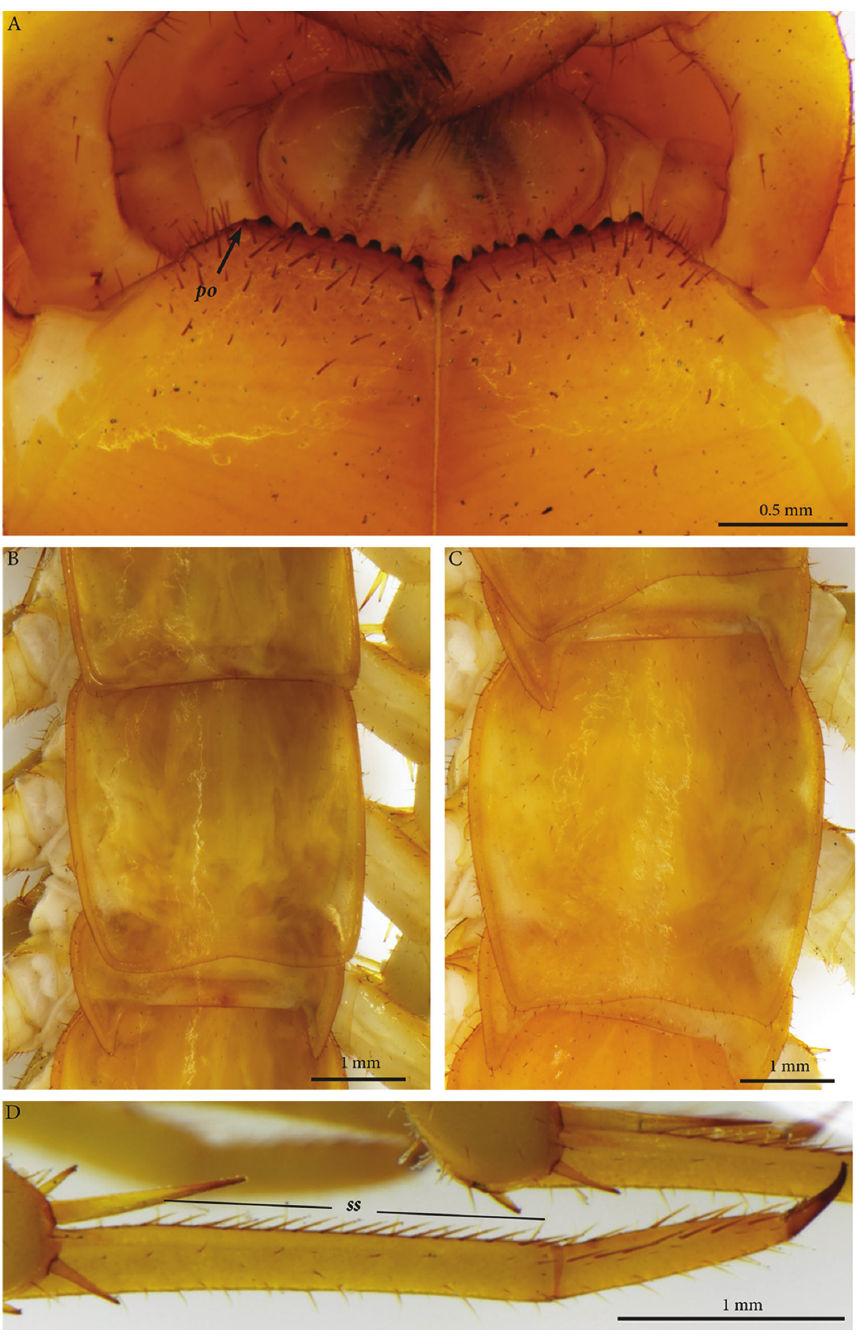
Figure 3. Eupolybothrus liburnicus sp. n., holotype, coxosternum, tegites and leg. A Close-up of coxoster- num, ventral view B TT7-9, dorsal view C TT11-13, dorsal view D Tarsi 1, 2 and pretarsus of midbody leg. Abbreviations: po : porodont, ss : seriate